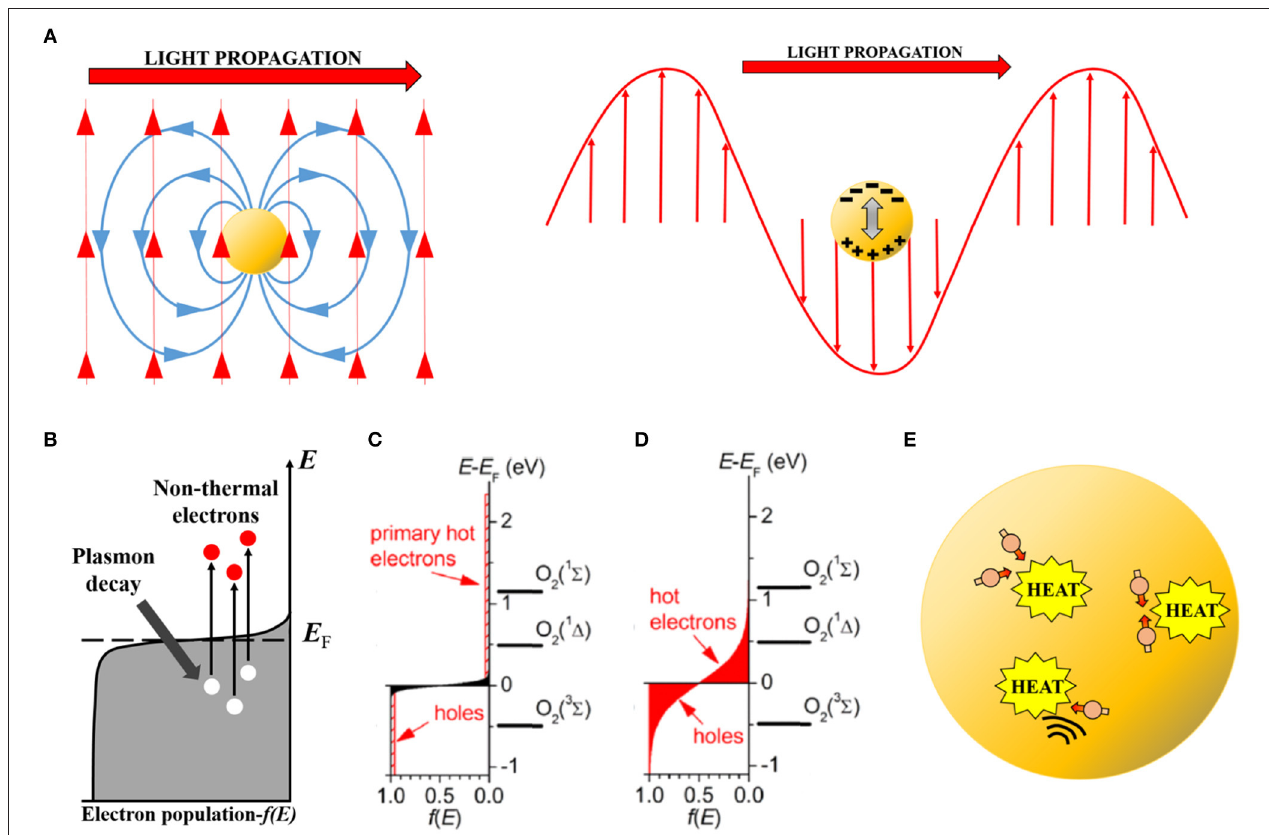
FIGURE 1 | Conceptual scheme showing the different steps in the induction and decay of a plasmon excited in a metal nanoparticle. (A) Left, initial electromagnetic induction of an electric field (blue) by the impinging optical electromagnetic field (red). Right, induced internal dipole (plasmon) in the nanoparticle by the optical field (note negative and positive induced charges). (B) Non-thermal electron excitation by plasmon decay. Electrons (red circles) are pumped to high energy levels leaving behind holes (white circles). (C) Initial population of non-thermal electrons in an intensively excited (by pulsed laser) nanoparticle. Note that electrons reach energies of 2.5eV and left behind holes of equal energetic magnitude. Molecular oxygen electronic levels have been included on the energy axis for comparison. (D) Hot-electron (-hole) populations (red zones) after non-thermal electron (-hole) scattering. Electrons and holes are more abundant than in (C) and their energies are still large (up to 1eV). The first excited state O 2 ( 1 1 ) of molecular oxygen can be efficiently induced under this condition. (C,D) Reproduced with permission from Chadwick et al. (2016) . (E) Hot electrons (dull red circles) and phonons (black waves) scatter, transferring their excitation energy to the nanoparticle lattice which increases its temperature and that of the environment by heat